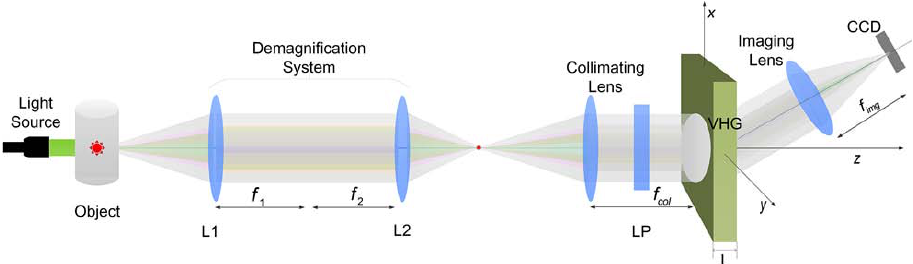
Fig. 4. Schematic of the spectral selective VHI system for detecting °uorescent objects within di®usive medium. Light source provides uniform excitation illumination in the transmission mode. The °uorescence emitting from the °uorescent object in the phantom is collected through the demagni¯cation system and forms a real image on the detector, CCD, after being di®racted by VHG. LP: long-pass ¯lter.